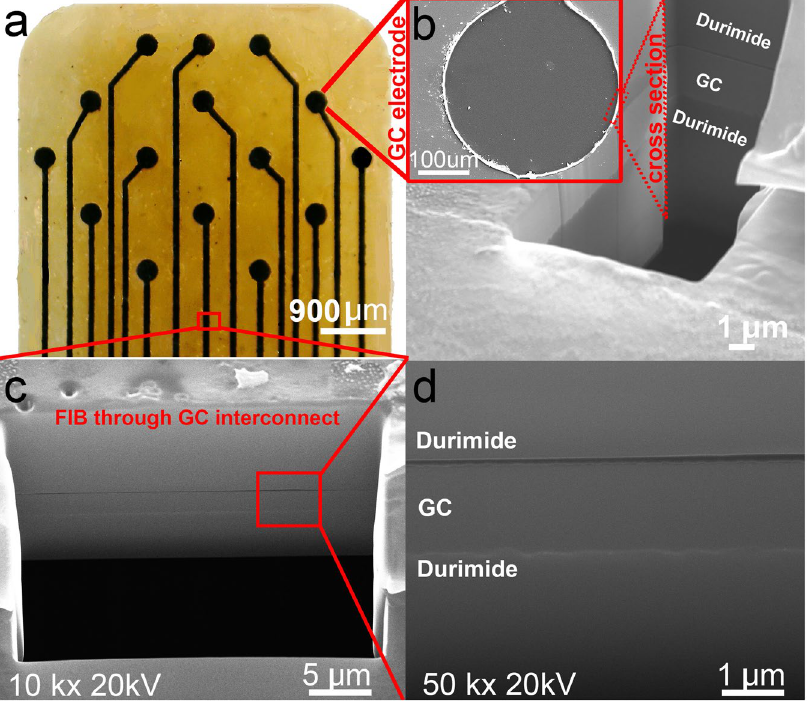
Figure 2. Details of aGC neural probe. ( a ) 15-channel aGC ECoG probe, ( b ) In inset: Magnified SEM image of a single microelectrode in the ECoG probe. Also, FIB cross-section of the GC microelectrode taken at the edge between GC and Durimide is shown revealing a seamless integration of the layers. ( c ) Expanded view of FIB cross-section taken at a GC wire trace leading to one of the microelectrodes, ( d ) High-resolution (50,000 × ) FIB image of a cross-section taken through a GC wire trace. Box in bottom of ( a ) shows the location where FIB through GC interconnect was taken. Note that there are no adhesion layers or metal layers in aGC probes.